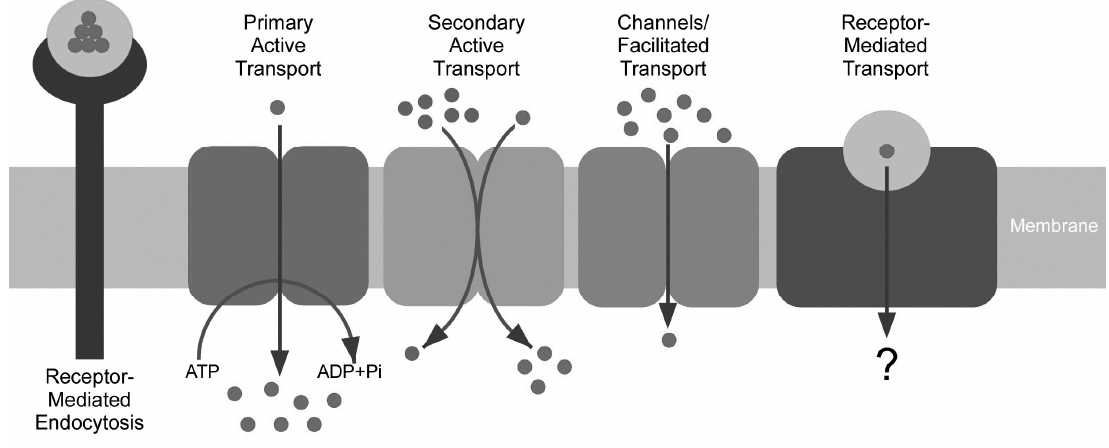
Figure 2. Comparison of STRA6-mediated vitamin A uptake from holo-RBP (right diagram) with known cellular uptake mechanisms including receptor-mediated endocytosis, primary active transport, secondary activity transport, channels and facilitated